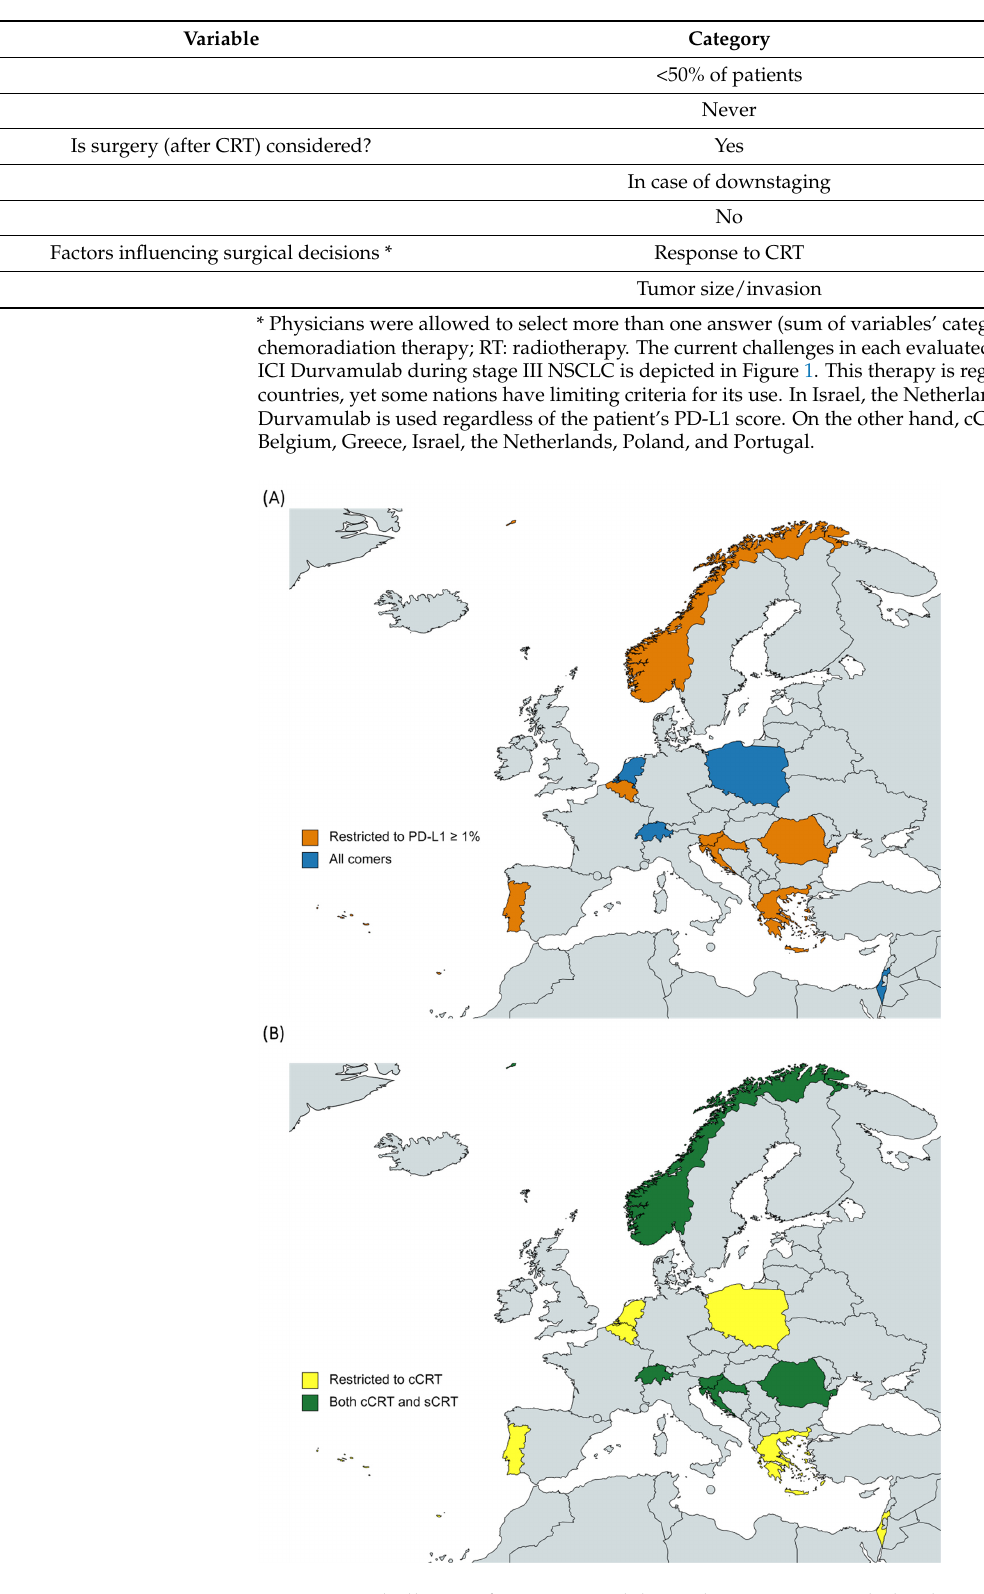
Figure 1. Challenges for Durvamulab implementation in daily clinical practice ( A ) Regulatory criteria for using Durvamulab regarding PD-L1 expression; ( B ) Restrictions of CRT (either concurrent or sequential).